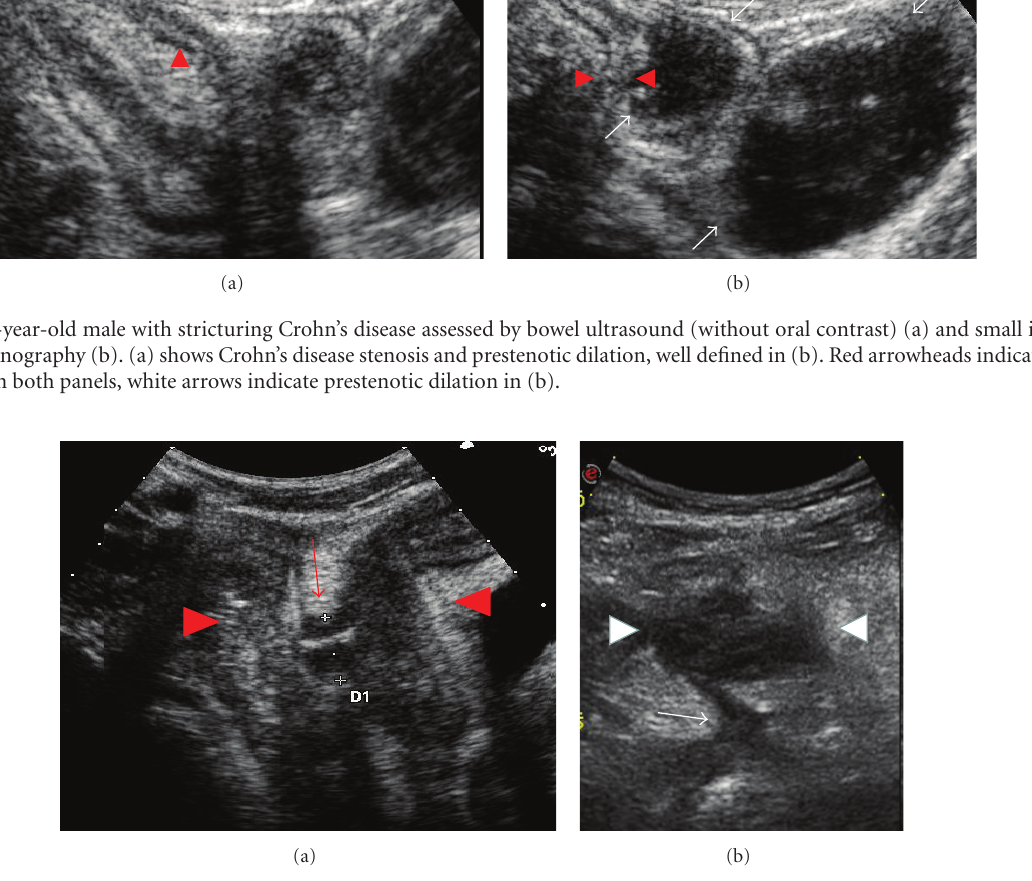
Figure 3: Bowel ultrasound in a 22-year-old female with ileocolonic Crohn’s disease. In (a) red arrow indicates enteroenteric fistula (defined as a hypoechoic track with a hyperechoic content) between diseased ileal loops with bowel wall thickness (red arrowheads). In (b) a small abscess (white arrowheads identify a roundish anechoic lesions with irregular walls, presenting internal echoes) with fistula (white arrow) was identified in the same